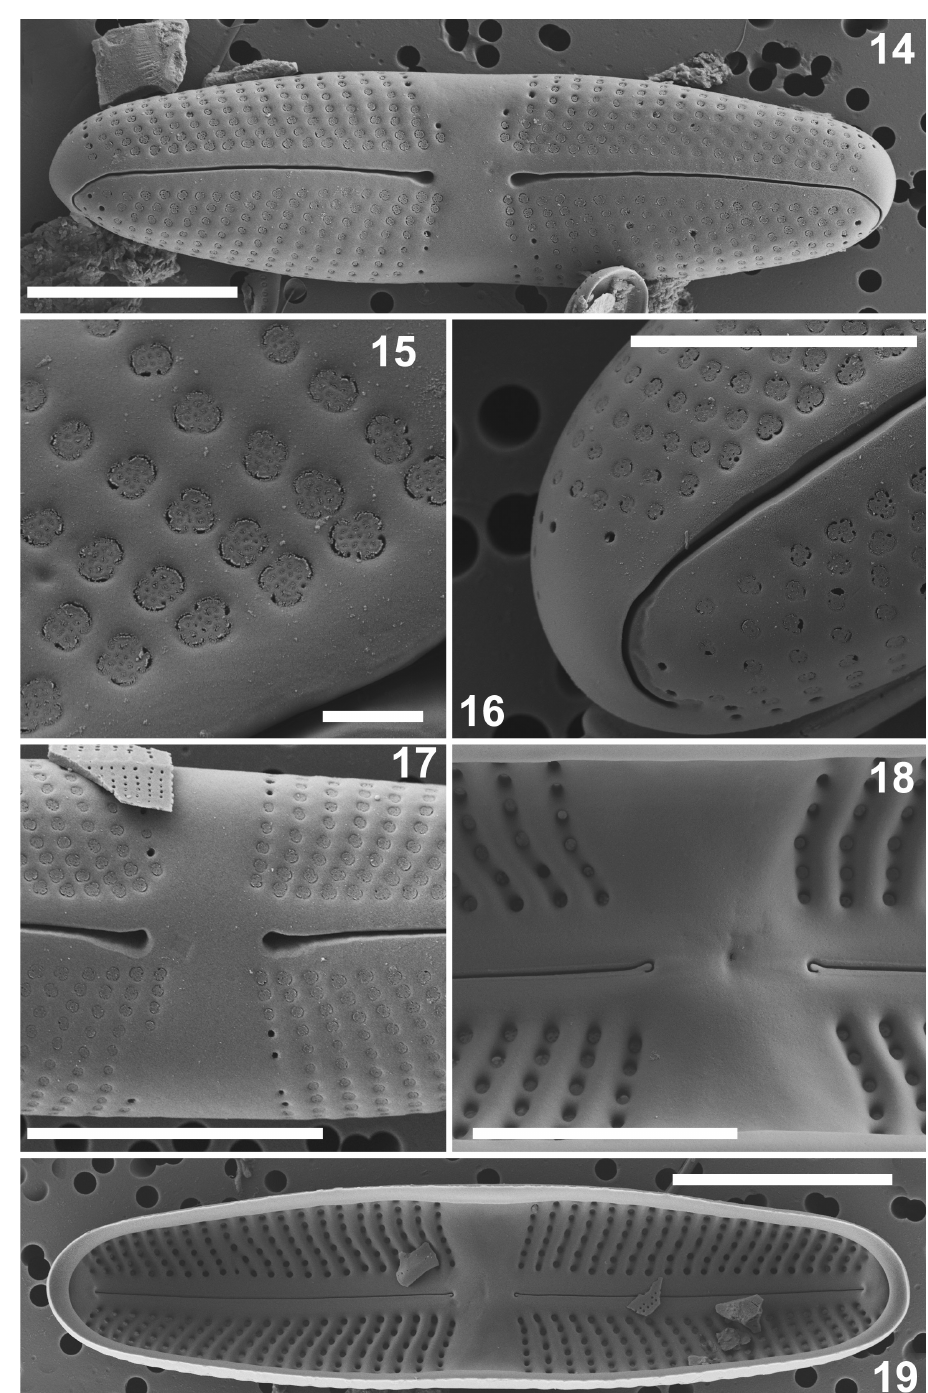
Figs 14–19. Achnanthes kohleriana Kopalová, Zidarova & Van de Vijver sp. nov. Scanning electron micrographs of the type population from Deception Island (South Shetland Islands, Antarctica). 14 . SEM external view of an entire raphe valve. 15 . SEM external detail of the areolae with the typical cribrate structure. 16 . SEM external view of the distal raphe ending. 17 . SEM external detail of the central area. 18 . SEM internal detail of the central area showing the hooked proximal raphe endings. 19 . SEM internal view of an entire raphe valve. Scale bars represent 10 µm for Figs 14 & 19, 1 µm for Fig. 15 and 5 µm for Figs